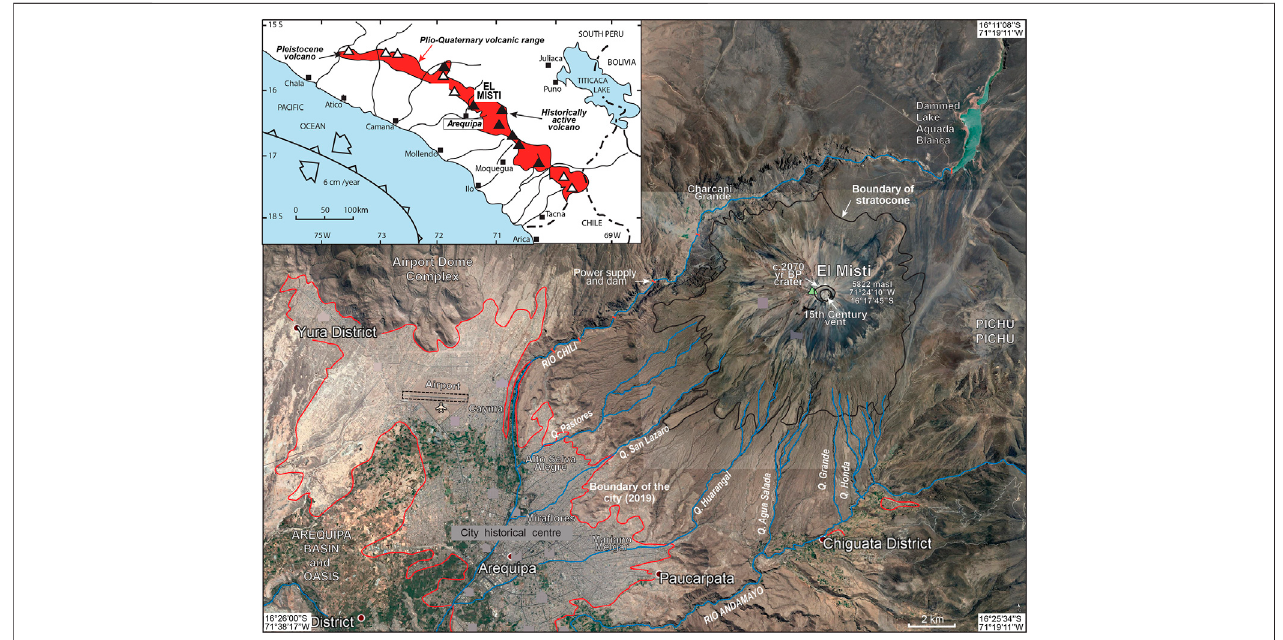
FIGURE 1 | Google Earth image of El Misti volcano showing the principal geological features, the drainage network in blue (Río Chili Valley and its tributaries Quebradas (cid:2) seasonal ravines), and the urban area of the city of Arequipa (red line). The bold line indicates the boundary between El Misti stratocone and its ring plain. Inset: location of El Misti volcano in the central volcanic zone in south Peru.